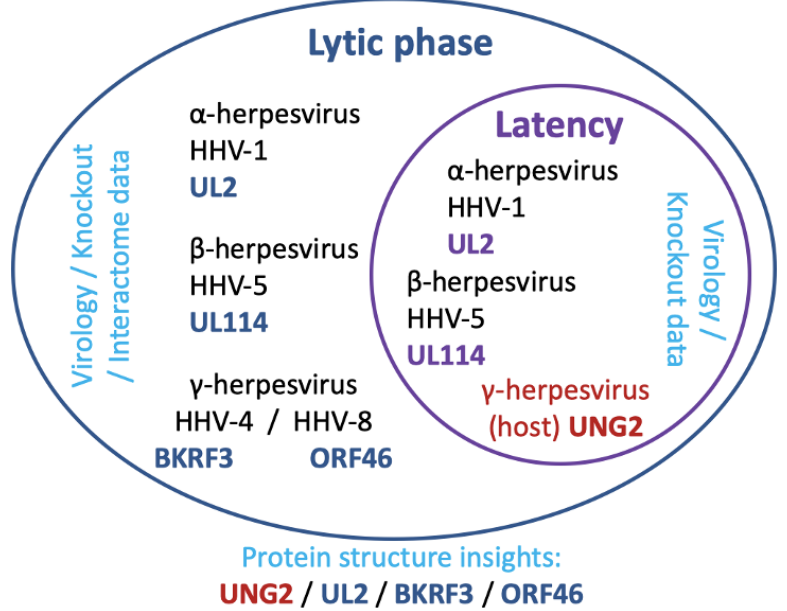
Figure 6. The latent and lytic phase of herpesviruses and relevance to uracil-DNA glycosylase. The simplified schematic depicts a cell cytosolic compartment (outer ellipse) with a nucleus (interior ellipse). Subfamily and virus are indicated in black text with uracil-DNA glycosylase encoded by that virus in blue text. Placement of text indicates the location UDG is currently thought to act (latent phase in the nucleus, and lytic phase in the cytosol) and the type of evidence supporting the premise (cyan text). Host cell encoded UNG2 is indicated with the named virus subfamily in dark red text, and placement indicates the phase of action (latency reactivation).